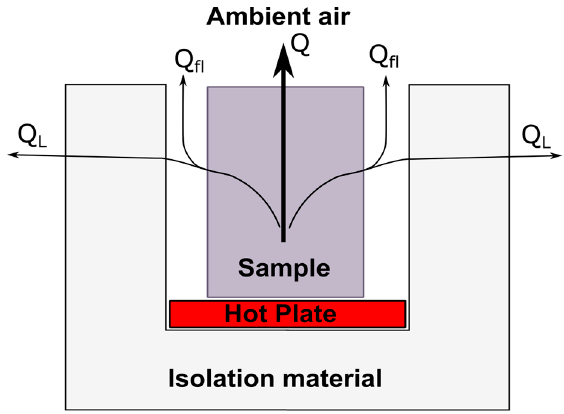
Figure 2. Ambient hot box schema with main thermal paths.